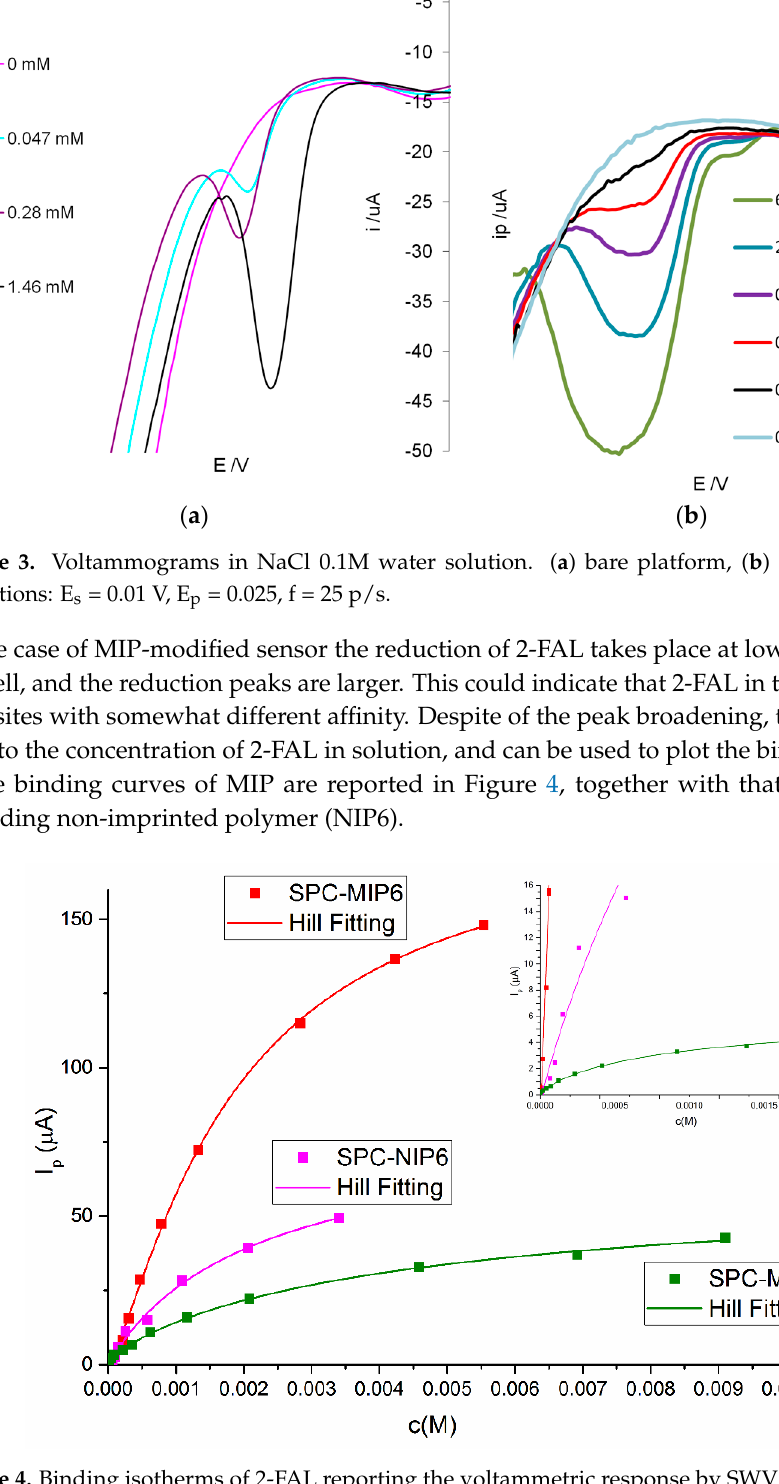
Figure 4. Binding isotherms of 2-FAL reporting the voltammetric response by SWV at the following conditions: E step = 0.03 V; E pulse = 0.065 V; f = 28 pulse/s. Sensor: SPC-MIP6 (red line), SPC-MIP5 (green line), SPC-NIP6 (magenta line).